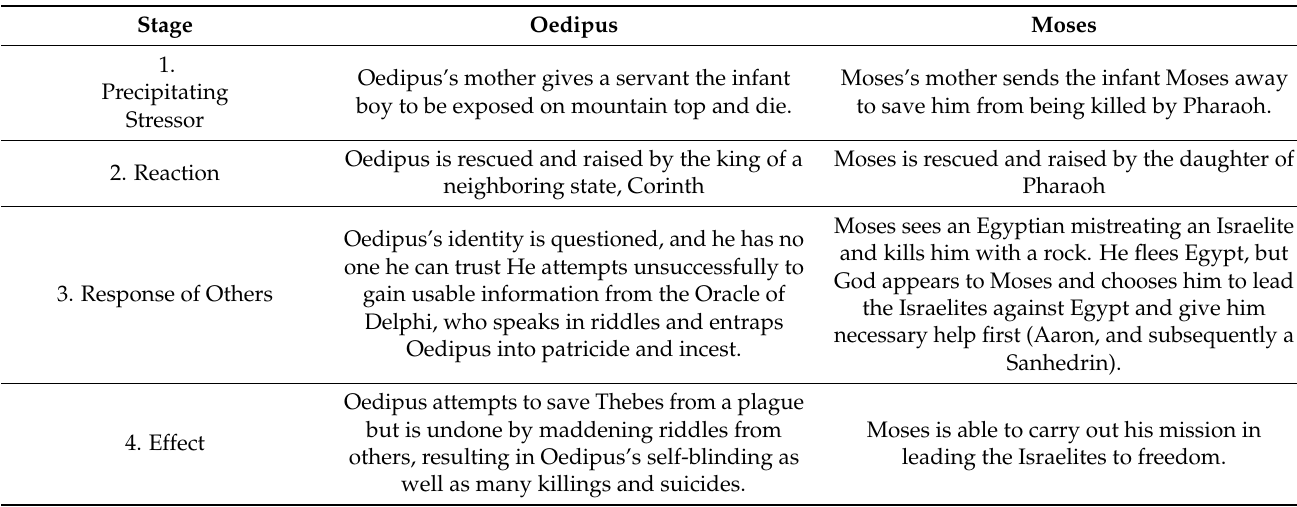
Table 8. Moses against